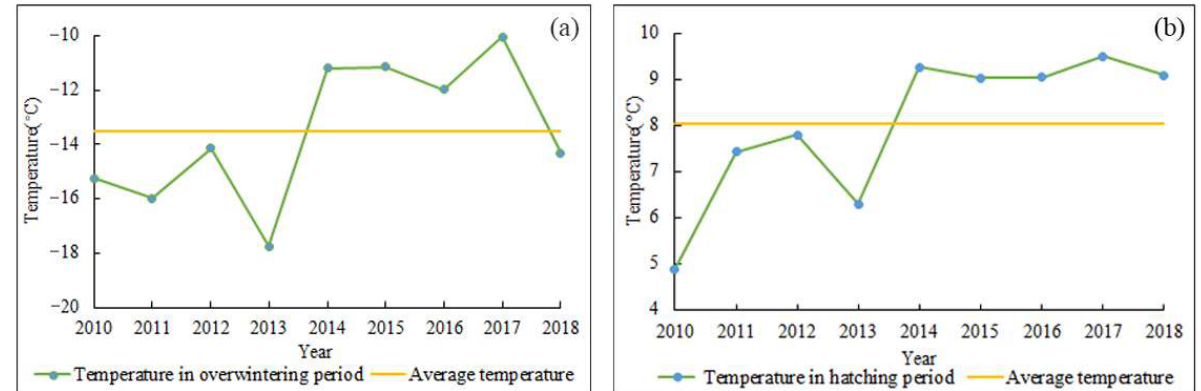
Figure 7. ( a ) Overwintering period (December to February) temperature from 2010 to 2018; ( b ) hatching period (March to May) temperature from 2010 to 2018.